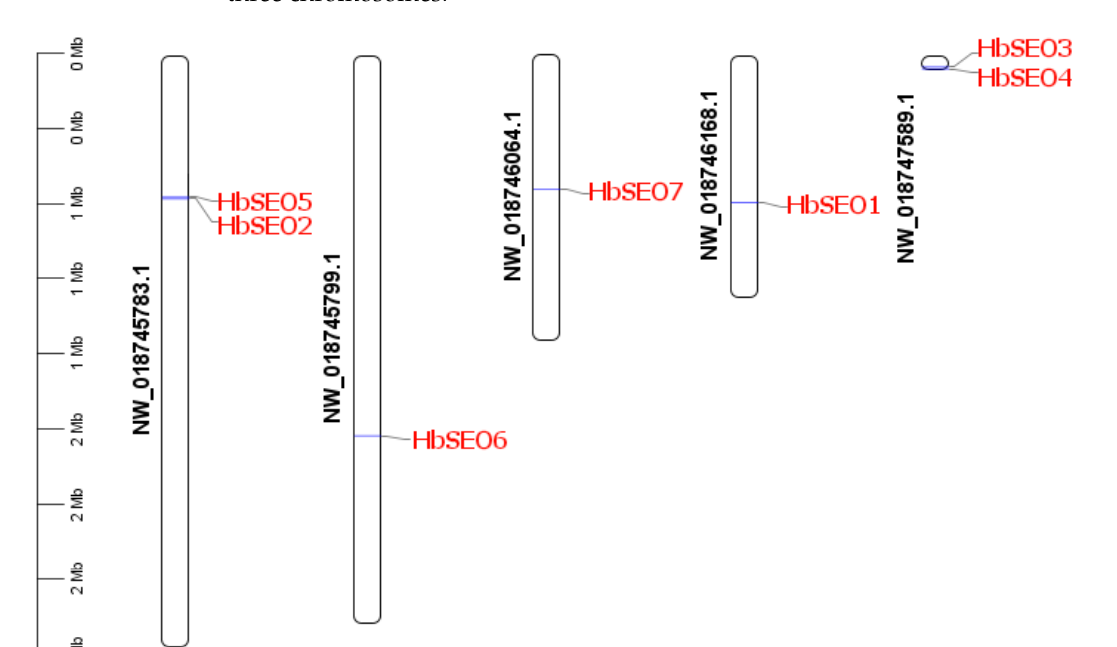
Figure 5. The chromosome localization of HbSEOs . The scale on the left side of the graph shows the length of the chromosomes in Megabase pairs (Mb). The chromosome number is indicated at the left of each chromosome.